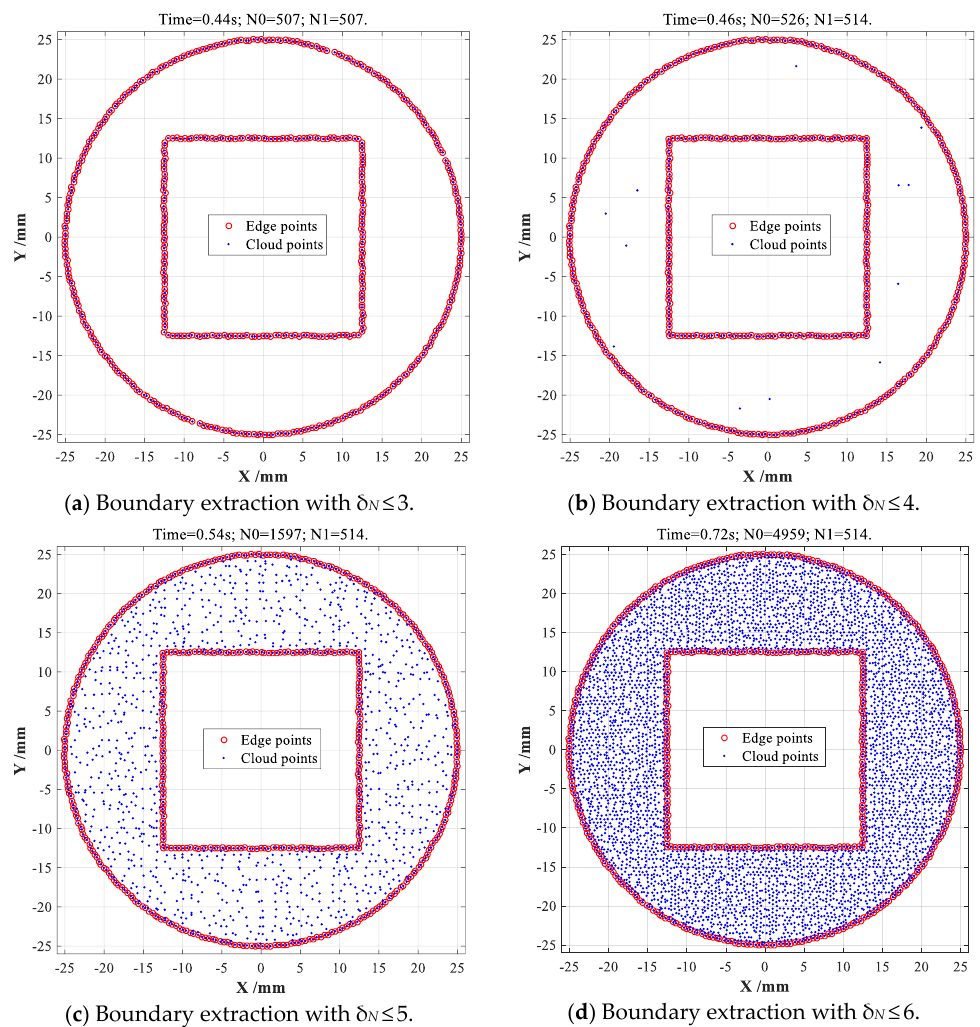
Figure 9. Statistical CDTM-based boundary extraction on CS-shaped point cloud with different δ N .